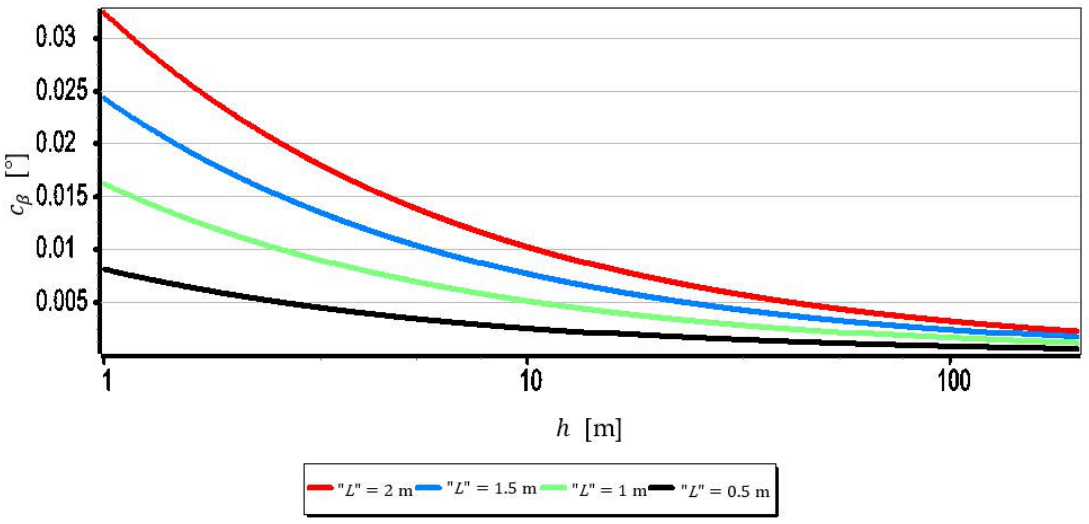
Figure 11. Measurement resolution of the horizon slope c β as a function of h for chosen wave heights “ L ” ( FOV H = 53.91 ◦ –SONY ILCE-7RM2).